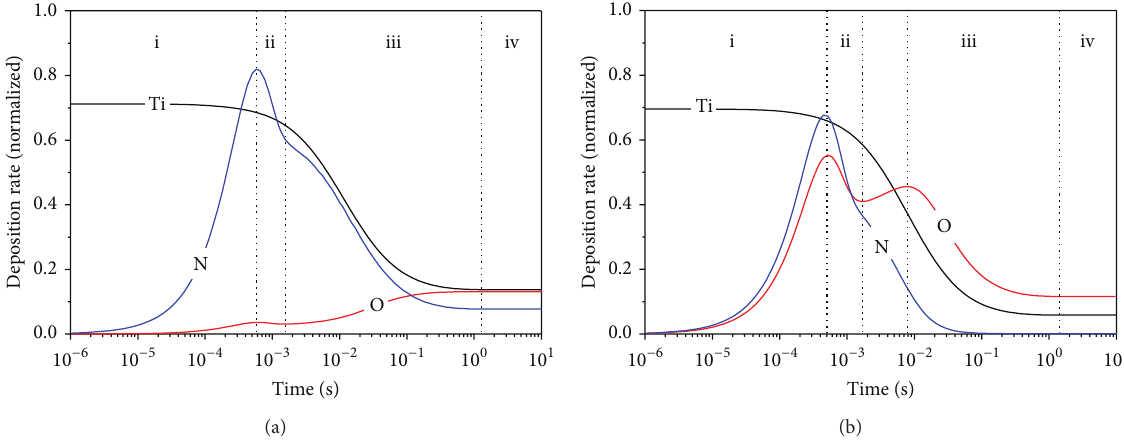
Figure 3: Deposition rate at oxygen flow rate of (a) 0.2 and (b) 3.5 sccm.